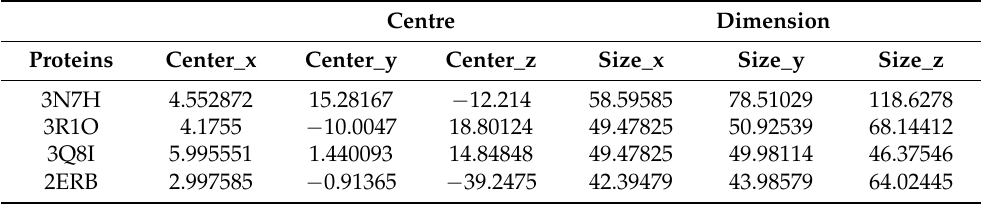
Table 1. Grid box information for the selection of the active pockets of the four odorant binding